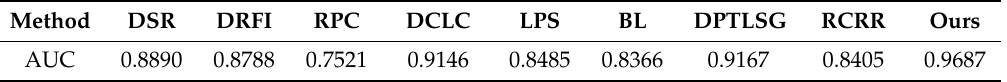
Table 4. The area under the curve (AUC) for different